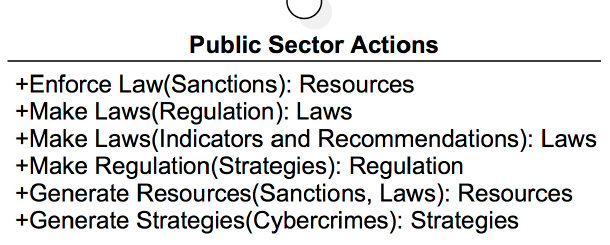
Figure 19. Public sector actions.